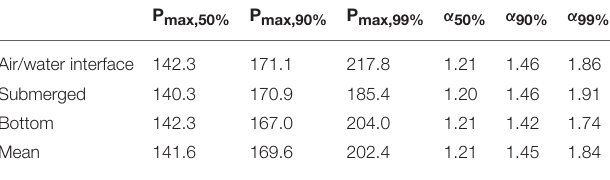
TABLE 5 | Cross section loss by section.